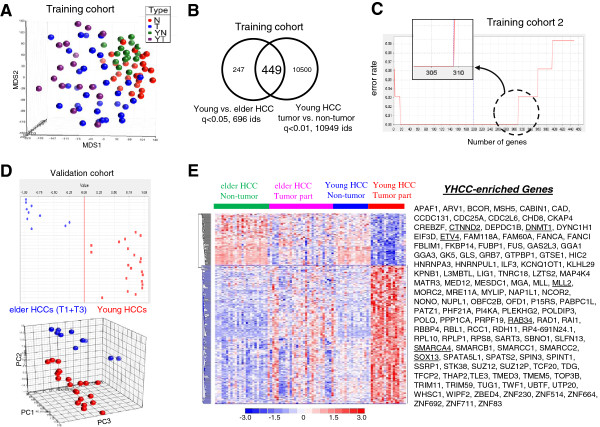
Distinct gene expression patterns in HCC from young or elderly patients. (A) A multidimensional scaling (MDS) plot using the whole transcriptome illustrates the mRNA profiles of normal and cancerous tissues. (B) A Venn diagram summarizing genes differentially expressed between the HCC tumor tissues of young and elderly patients, or between tumor and non-tumor yHCC samples. (C) Advanced signature training using a machine learning strategy and an independent testing elderly HCC data set. When probe sets were ranked by signal-to-noise ratios (weights), the top 309 features was the largest panel to give the lowest error rate (i.e., a best classification effect; upper panel). (D) The discrimination ability of the 309-probeset signature on the validation data set. The prediction strength plot (upper) and the PCA plot (lower) show the discriminating power of the identified 309 probe sets in separating young and elderly patients in the validation cohort. (E) A heat map shows the 309 probes sets differentiating young and elderly HCCs in the training data set 1, as well as discriminating tumor and non-tumor tissues. Columns represent tumor samples; rows represent probe sets. Genes in red: increased; in blue: decreased. Genes underlined: discussed in the text.